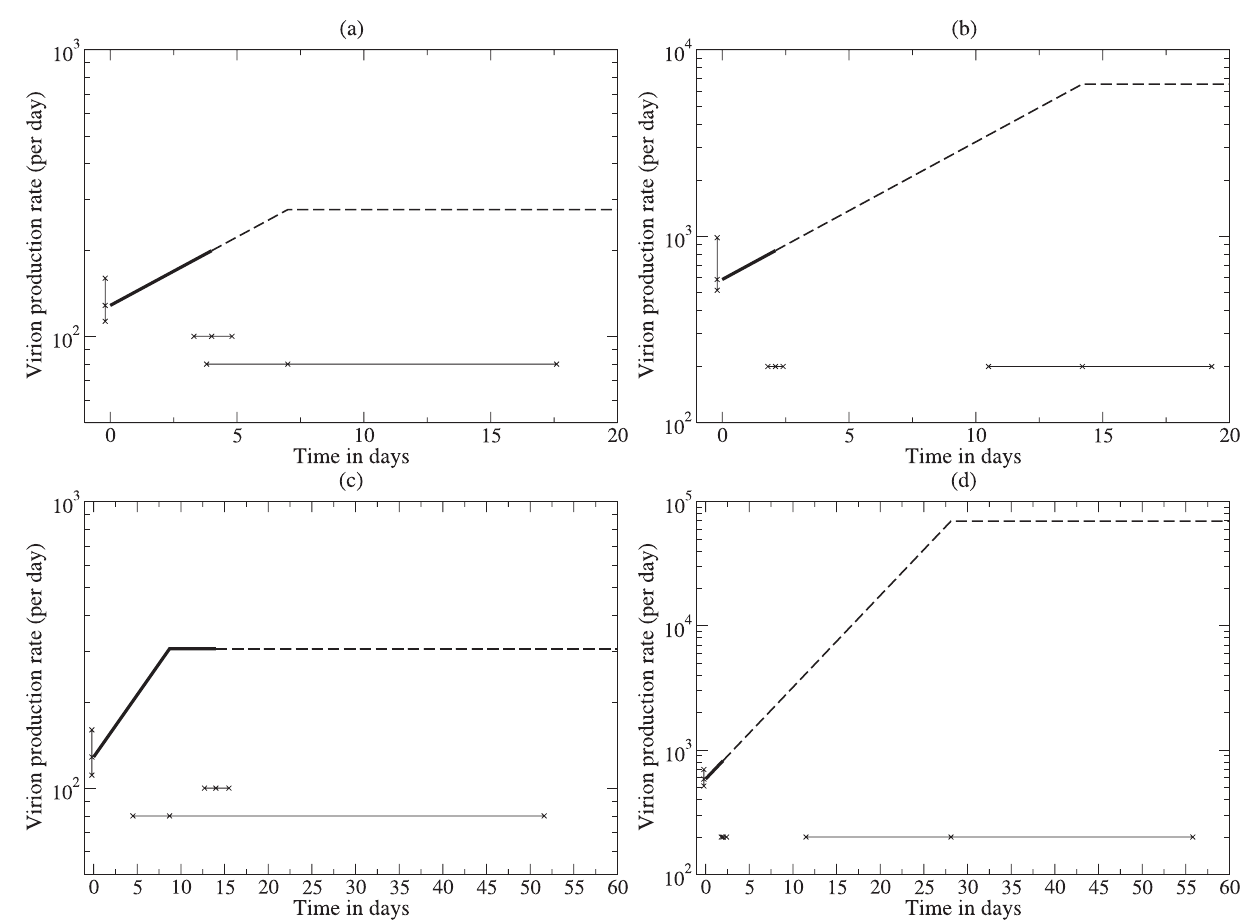
Figure 3. Viral production rates in the lymphoid tissue estimated by Reilly etal. [ 23 ] for resting (panels a,c) and activated cells (b,d) respectively. The top row of the Figure (Panels a,b) is the result when the mean of the prior distribution of the half-life resting cells is 4 days (and that of activated cells is 1.5 days). In the bottom row (c,d) the mean of the prior distribution of the half-life resting cells is 14 days (and that of activated cells remains 1.5 days). The median total production rate per cell is computed by integrating these curves up to the half-life of the cell (as indicated by the heavy lines) and amounts to 1479 and 1395 virions per activated cell and 644 and 3405 per resting cell (see the text). The horizontal and vertical lines marked by crosses denote the mean value with 95% credible intervals for the production rate at time zero, the half-life of the cell, and the saturation time of the production function [23].